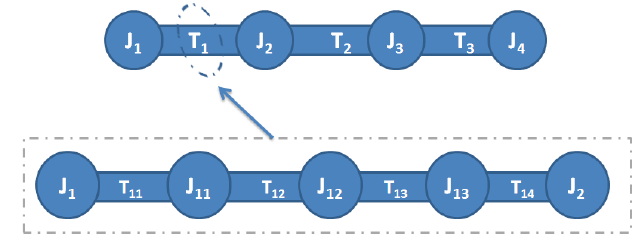
Figure 3: Topological description of the low voltage network under